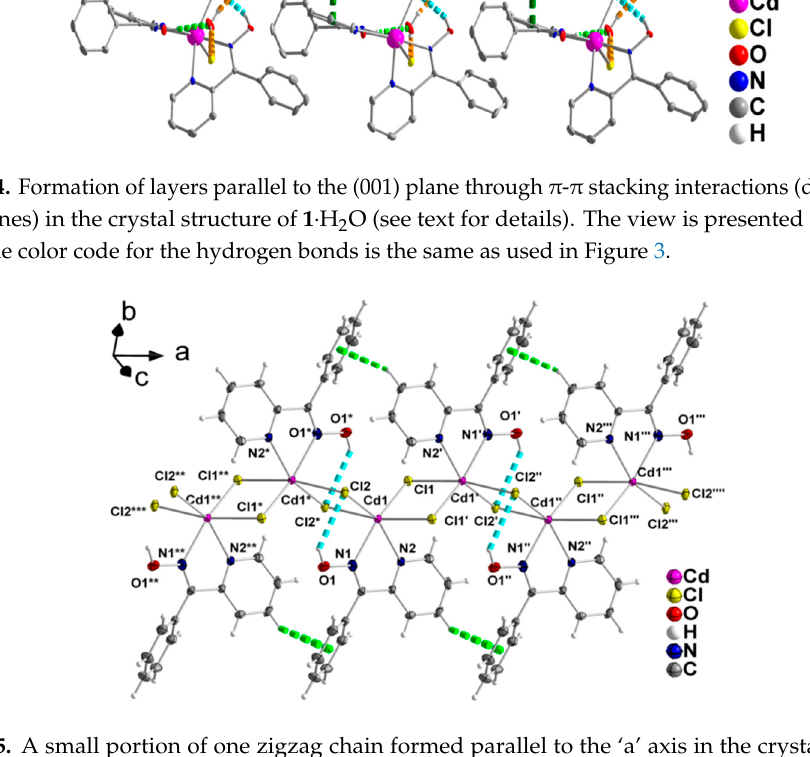
Table 3. Hydrogen bonding interactions (Å, deg) in the crystal structure of [CdCl 2 (phpaoH) 2 ] ∙ H 2 O ( 1 ∙ H 2 O).